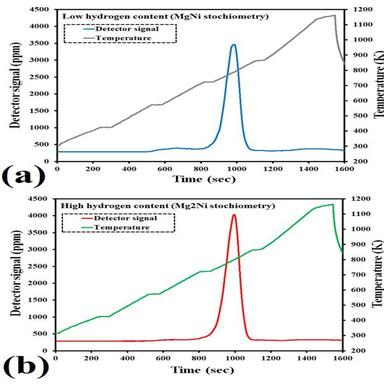
e The non-isothermal dehydrogenation testing determines the hydrogen release temperature range for the processed alloys with two different stoichiometry of (a) MgNi and (b) Mg2Ni.